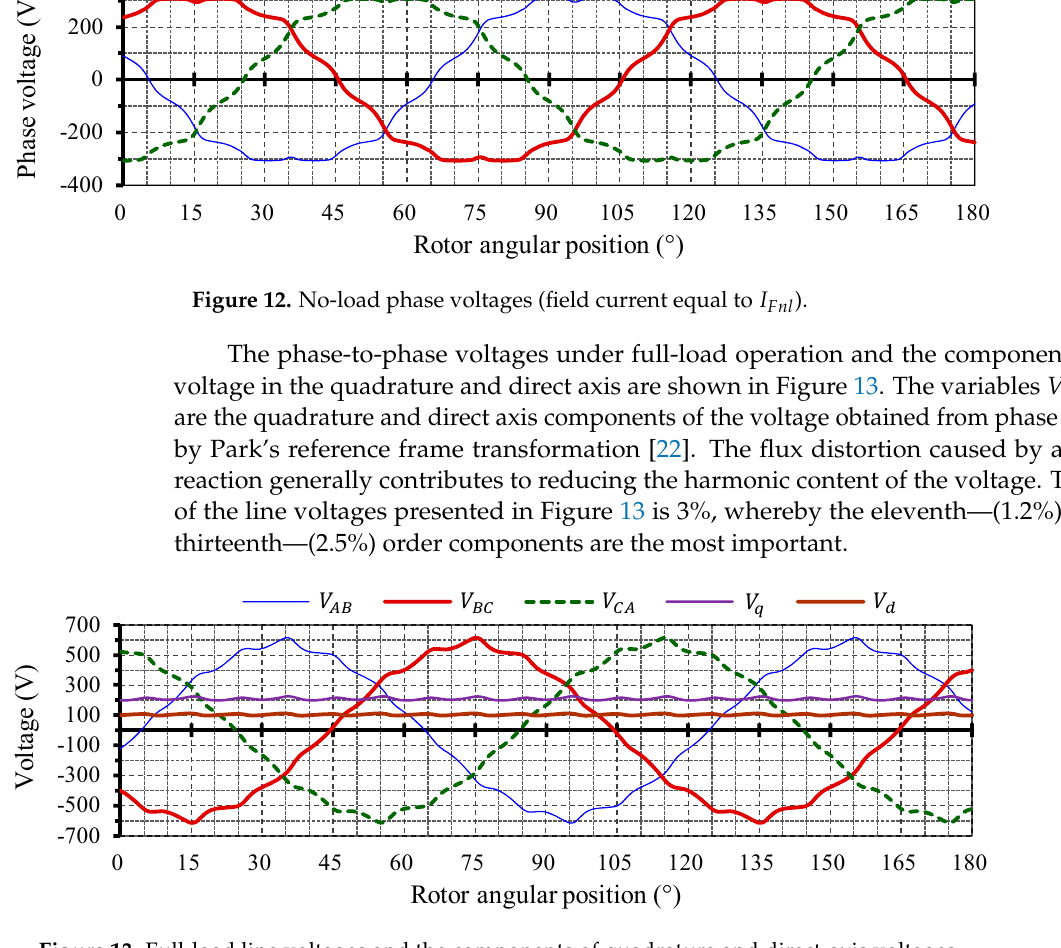
Figure 13. Full-load line voltages and the components of quadrature and direct-axis voltages. Figure 14 shows the armature currents and the components corresponding to quad- rature and direct axis. The THD of armature currents is 9%, where the most important is the third-order component, with 8.4%.